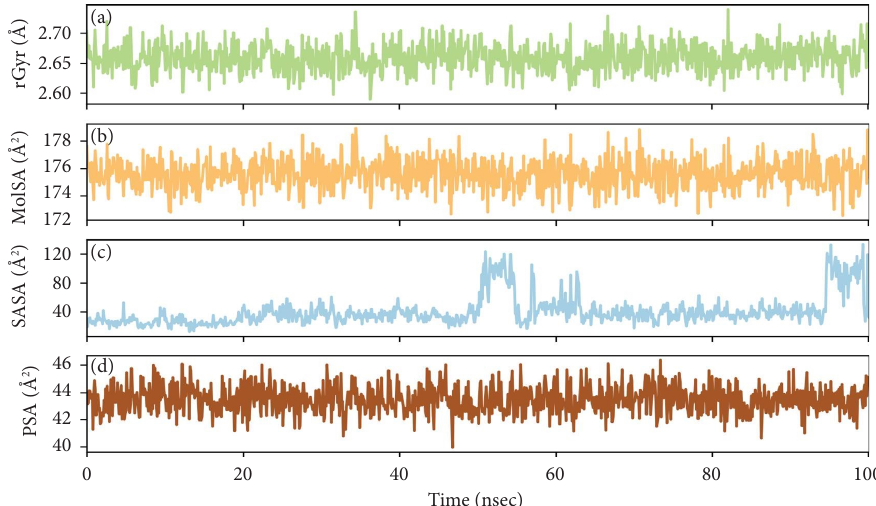
Figure 8: Dependencies of (a) rGyr, (b) MolSA, (c) SASA, and (d) PSA on simulation